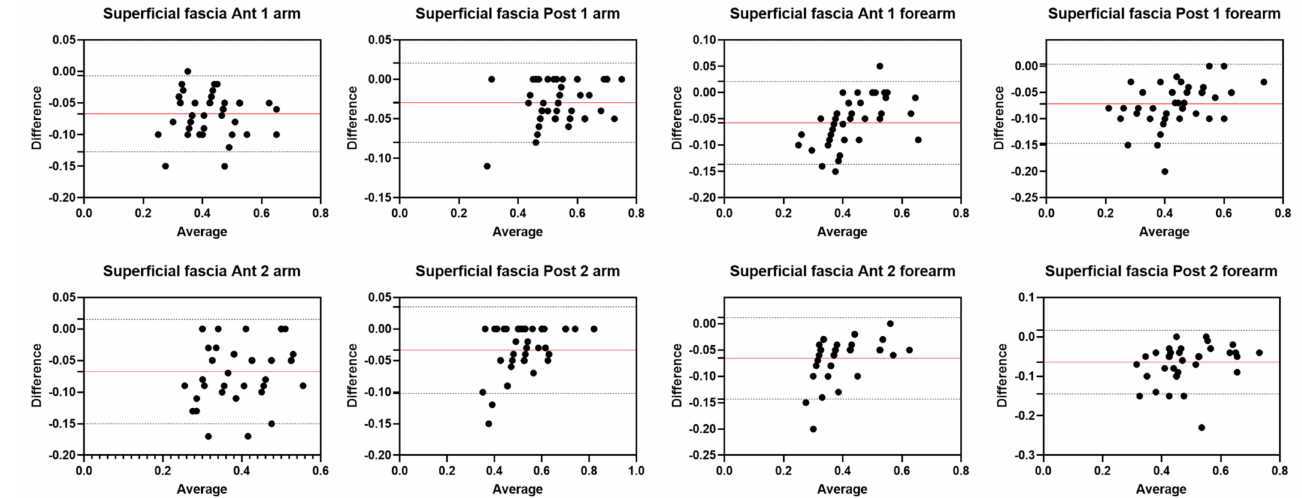
Figure 12. Bland–Altman plot comparing two raters (R1 and R2) measuring the US thicknesses of the superficial fascia of the arm and of forearm for the different/levels. Red line = bias or mean difference; dashed lines: 95% limits of agreement